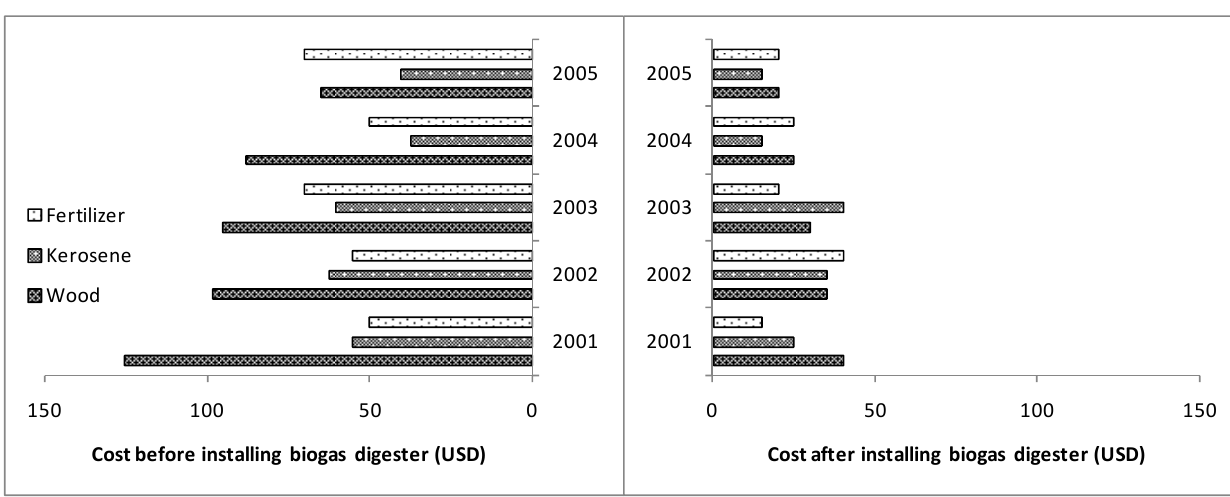
Figure 4. Costs of firewood, kerosene and fertilizer before and after installing the biogas digester from 2001 to 2005 in India